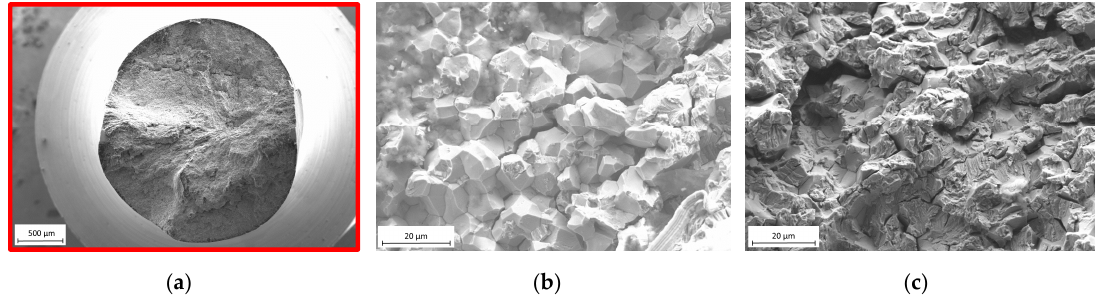
Figure 11. Fracture surface of the SSRT in 42 wt.% MgCl 2 at 120 °C: ( a ) markedly reduced reduction in